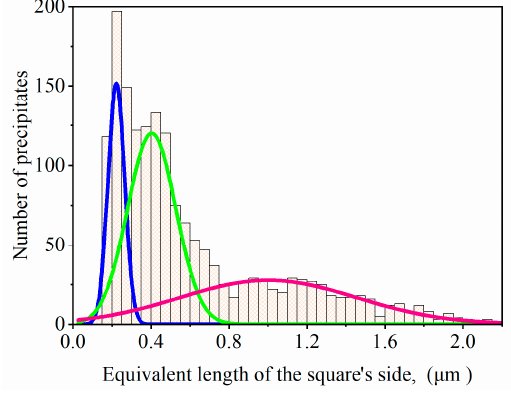
Figure 3. Histogram of equivalent length of the square's side of γ ' precipitates.